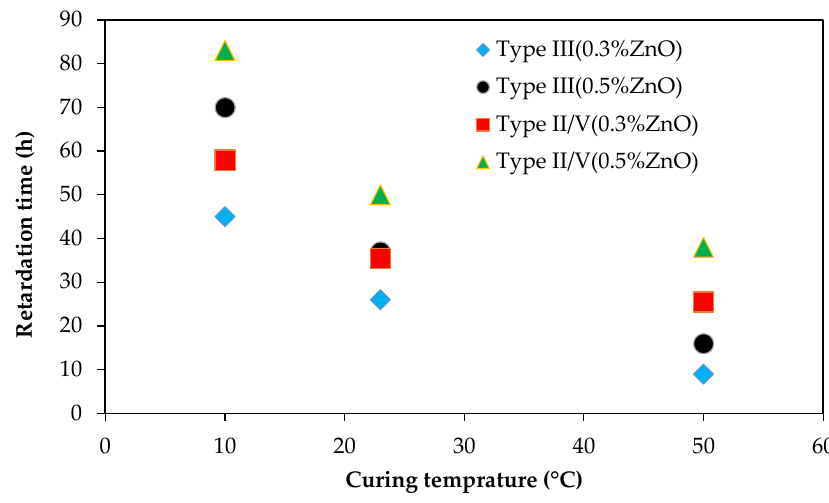
Figure 4. Correlation between curing temperature and retardation time.